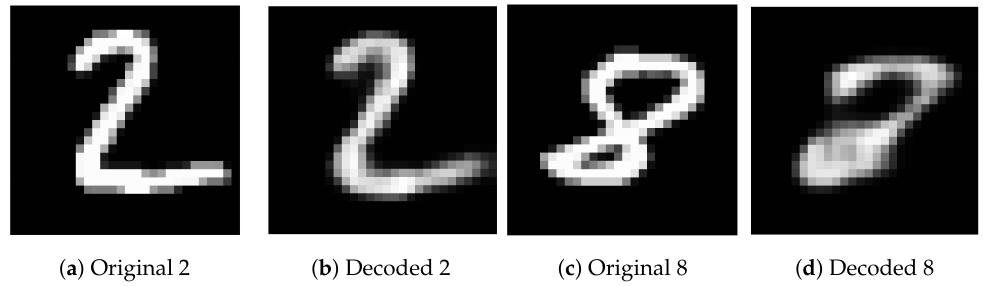
Figure 2. Comparison of reconstruction of a handwritten number two and a handwritten number eight with an autoencoder trained to reconstruct images with a handwritten number